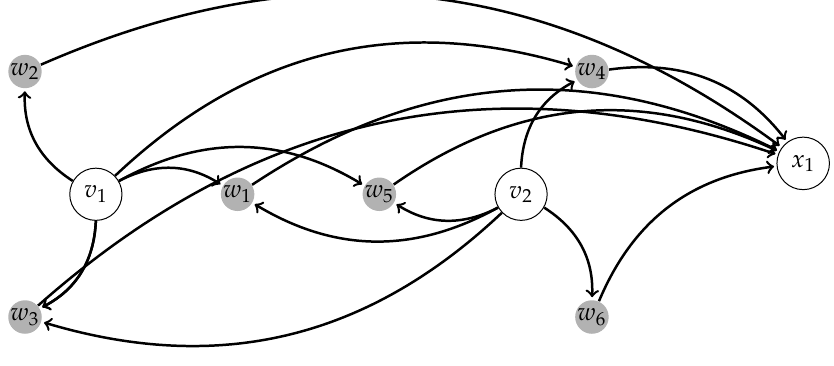
Figure 1. This image shows the control of one of the x -coordinates of human body motions by a network consisting of two oscillators ( v 1 , v 2 ) and a radial basis function (RBF) network with N = 6 nodes. The graph consists of eight nodes denoted by v 1 , v 2 , w 1 , w 2 , w 3 , w 4 , w 5 , w 6 . Each node w i corresponds to a contribution of a radial basis function Φ ( q − ¯ q ( j ) ) . The nodes v 1 , v 2 form the set of centers C and they affect w i . In turn, the nodes w i determine the output coordinate x 1